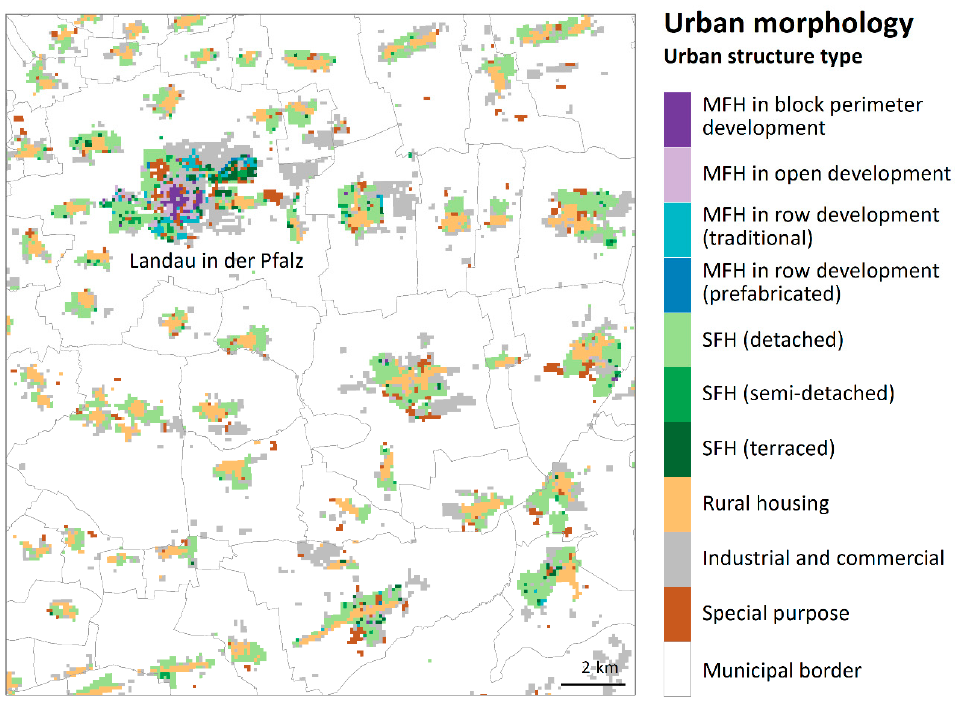
Figure 7. Derived urban structure type at the level of 100 m grid cells.